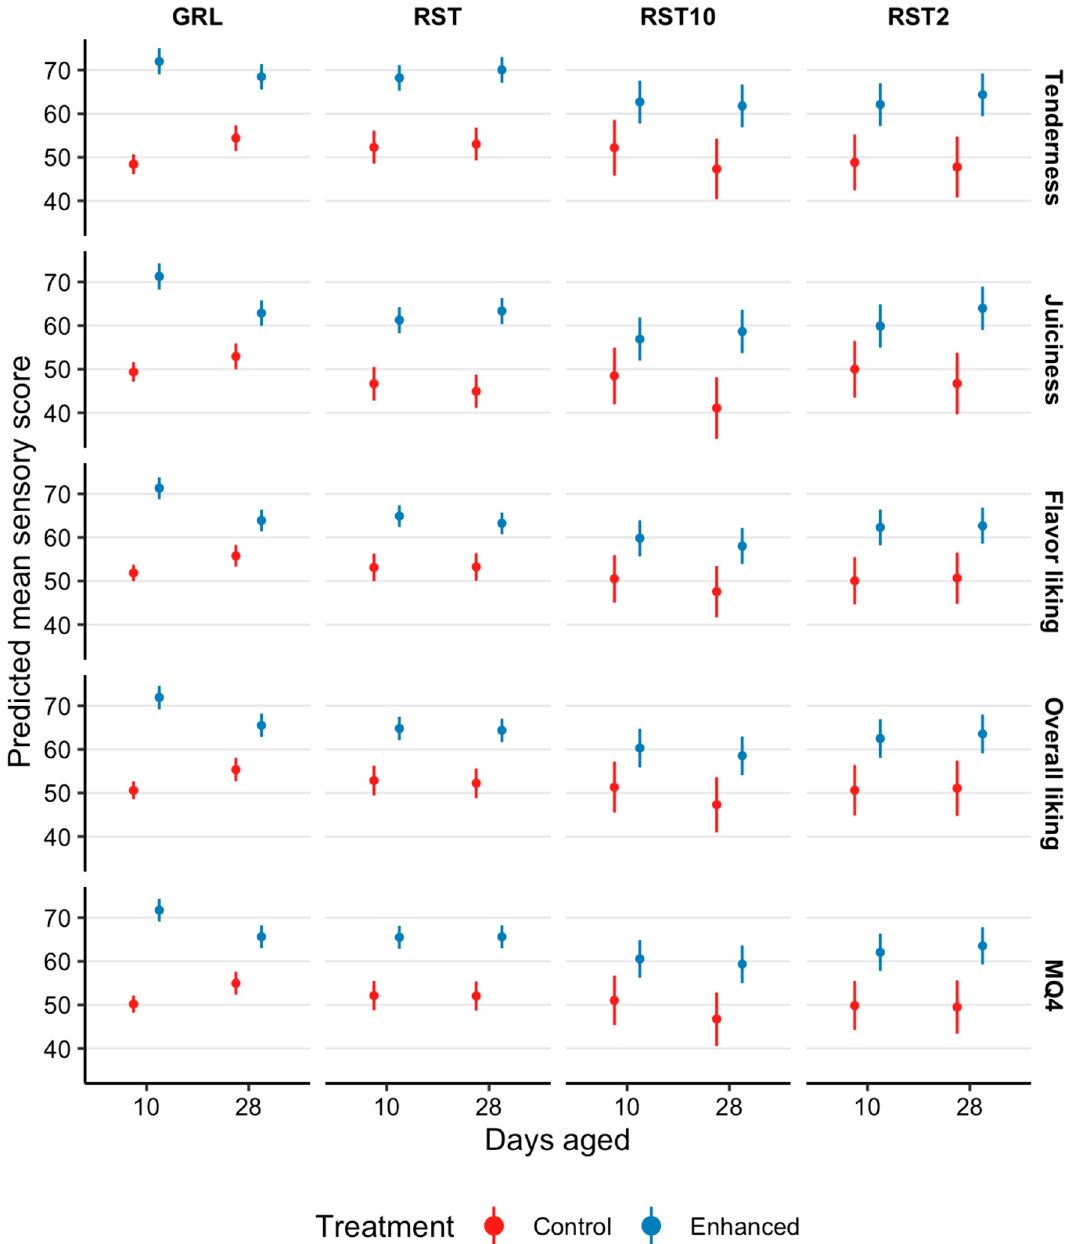
Figure 2. Estimated marginal means with 95% confidence intervals for tenderness, juiciness, flavor liking, overall liking, and eating quality (MQ4) scores of striploins (STR045; M. longissimus lumborum ) presented to consumers ( n = 2080) as grill (GRL), 10 mm hot roast (RST), 2 mm cold roast (RST 2 ), and 10 mm cold roast (RST 10 ) that were not infused (control) and infused with a kiwifruit extract (enhanced), and aged for 10 or 28 days.